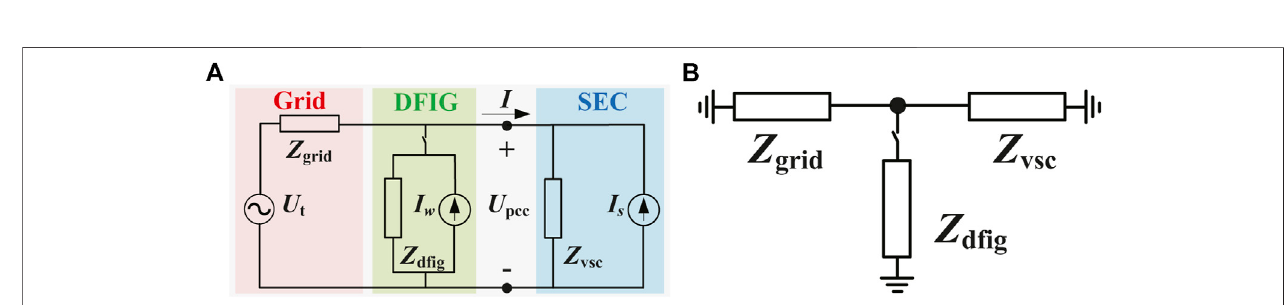
FIGURE 5 | (A) Equivalent circuit model of the whole system. (B) Equivalent impedance network model of the whole system.